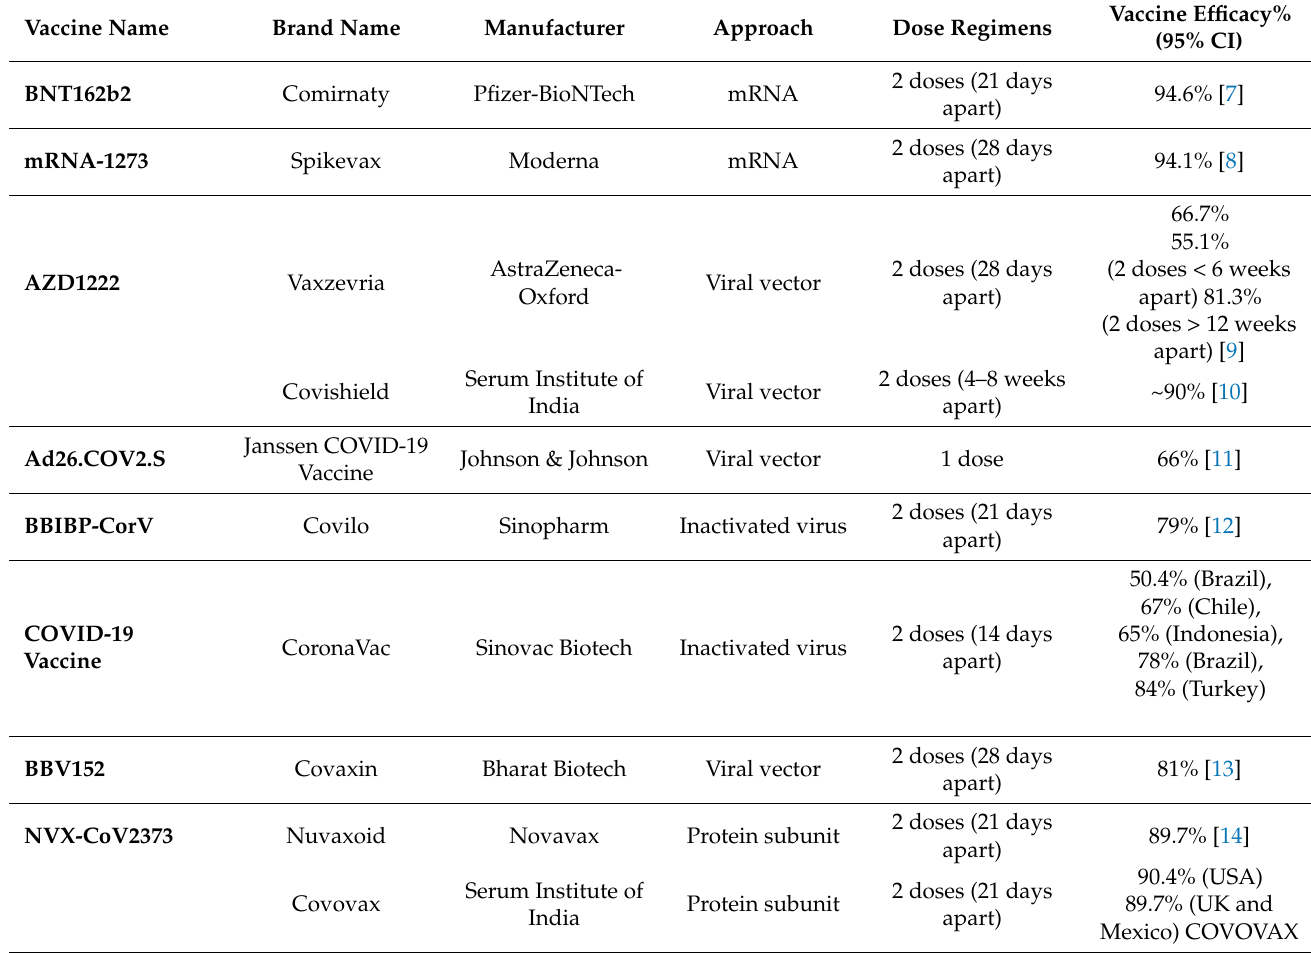
Table 1. WHO-approved COVID-19